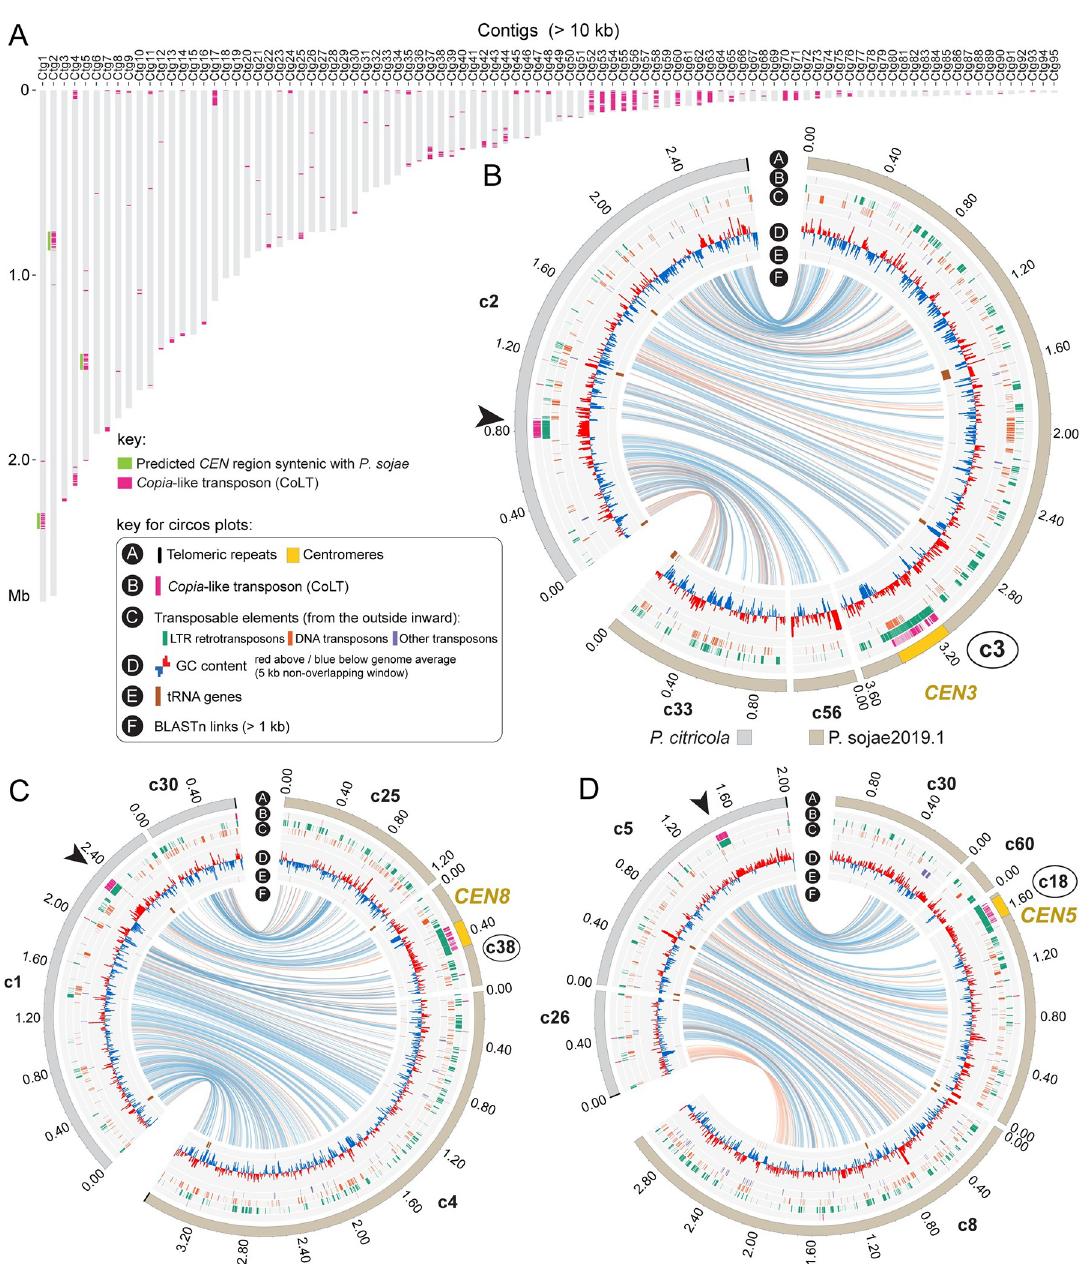
Fig 8. Genomic distribution of CoLT in the Phytophthora citricola genome. (A) Location of CoLT across all P . citricola contigs > 100 kb. (B-D) Circos plots comparing three P . citricola contigs that have CoLT clusters with the corresponding Psojae2019.1 contigs. In each panel, the outer track (bars) illustrates the contigs in the P . citricola or the Psojae2019.1 genome assemblies, which is color coded as shown below the Circos plot in panel B. Yellow regions indicate the locations of centromeres (CENP-A binding regions). Names of contigs harboring P . sojae centromeres are enclosed in circles. Blue and orange lines in track F link regions with synteny extending over 2 kb, with orange lines corresponding to inversions. CoLT clusters present in the P . citricola contigs are indicated by arrowheads. The flanking sequences of each CoLT cluster are syntenic with the regions surrounding the P . sojae centromere.